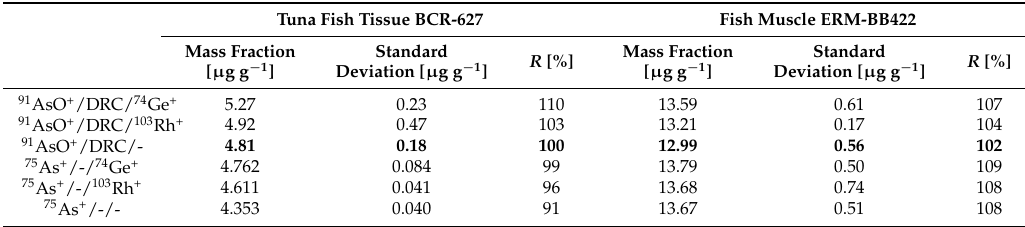
Table 1. Total arsenic concentration in certified reference materials of Tuna Fish Tissue BCR-627 and Fish Muscle ERM-BB422 in digested samples ( n =